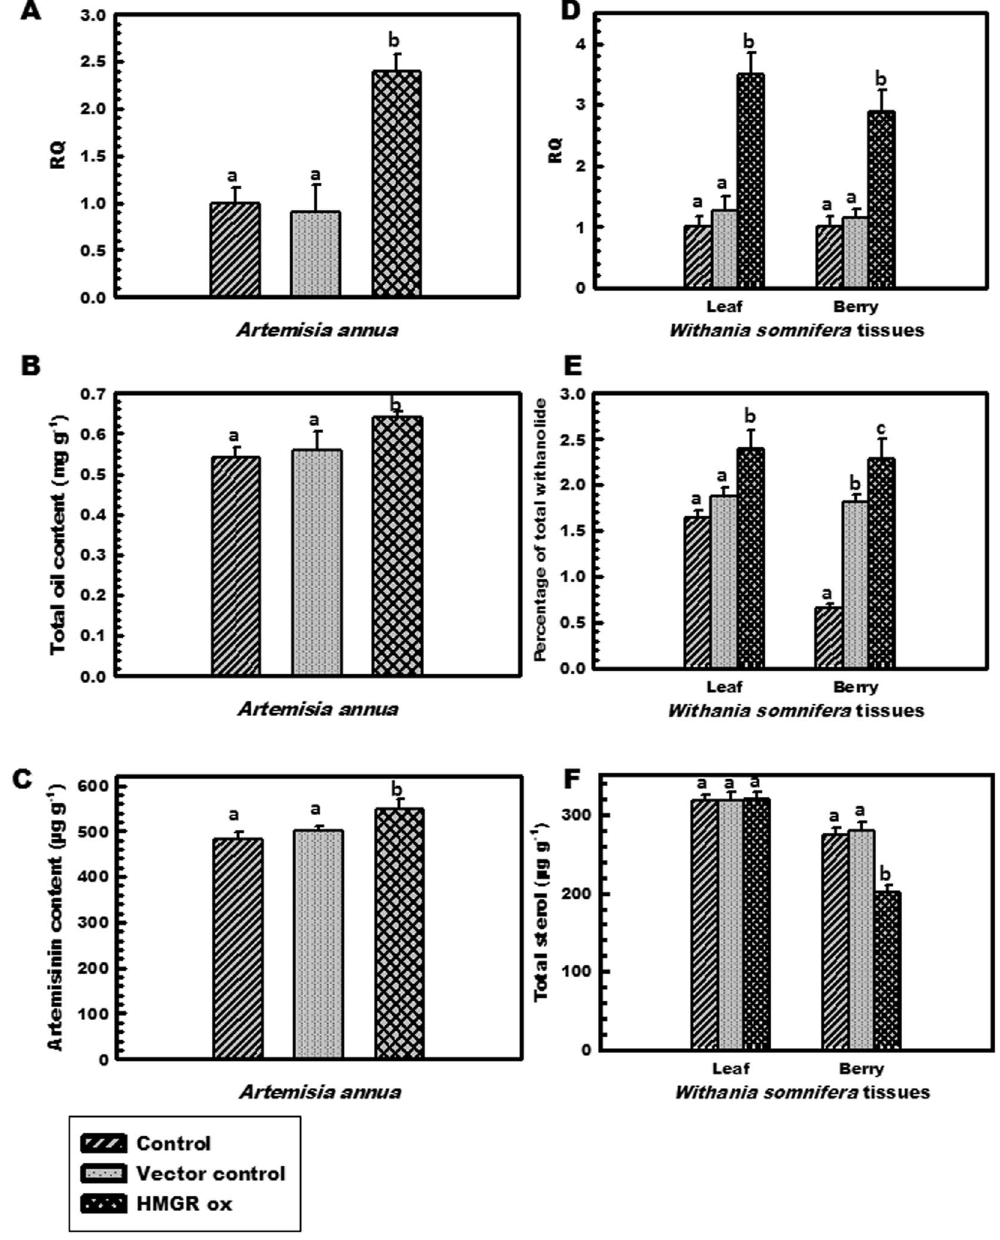
Figure 6. Expression profiles of OkHMGR transcript and secondary metabolite content in control and over- expressed lines of A . annua ( A ) OkHMGR mRNA transcript levels, ( B ) total essential oil content (mg/g FW g − 1 ), ( C ) artemisinin content ( µ g g − 1 ); and W . somnifera ( D ) mRNA transcript levels in leaf and berry, ( E ) total withanolide content (%), ( F ) total sterol content in leaf and berries ( µ g g − 1 ). Control represents